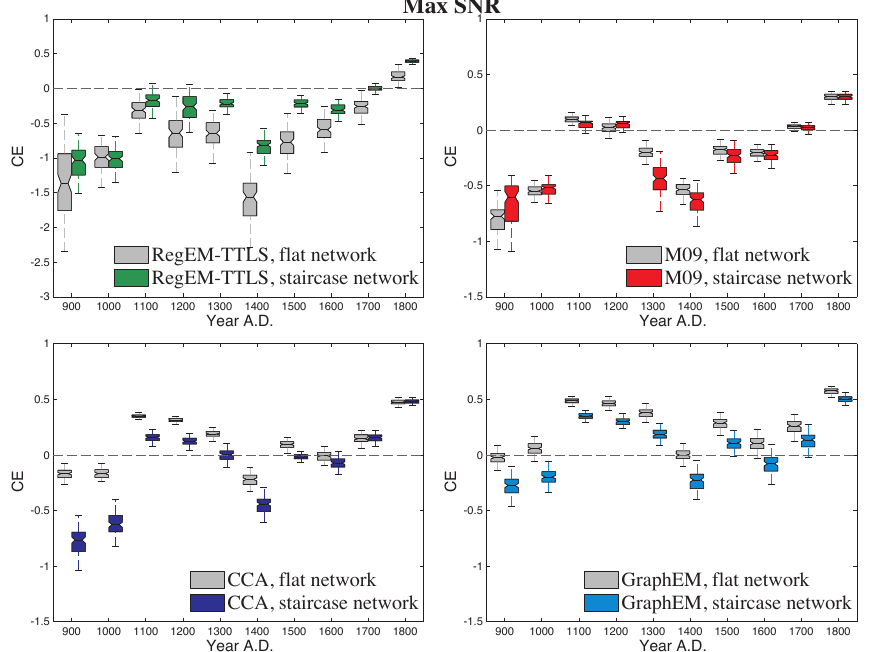
Fig. 8. Same as Fig. 7, but for the max SNR